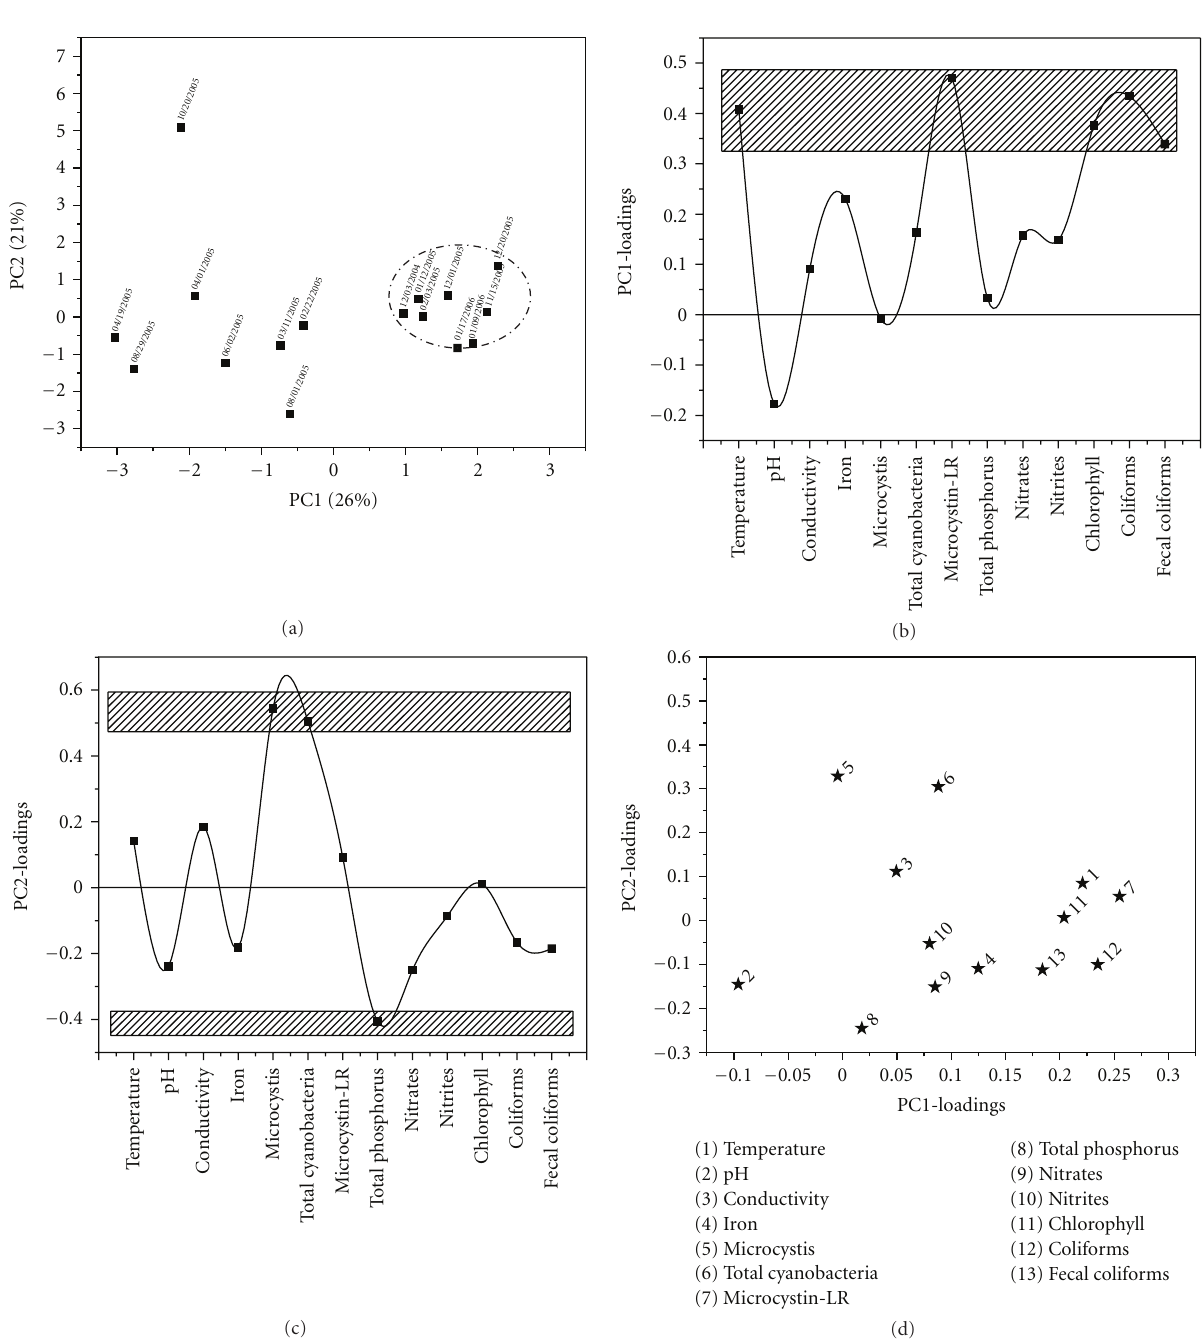
For all records and sampling points, the log normal and the extreme value distribution functions were chosen. The histo- grams of the records of total coliforms, M. aeruginosa, and microcystin at the three sampling sites (Stations 1–3) des- cribed by the selected distribution functions are presented in Figures 6, 7, and 8,